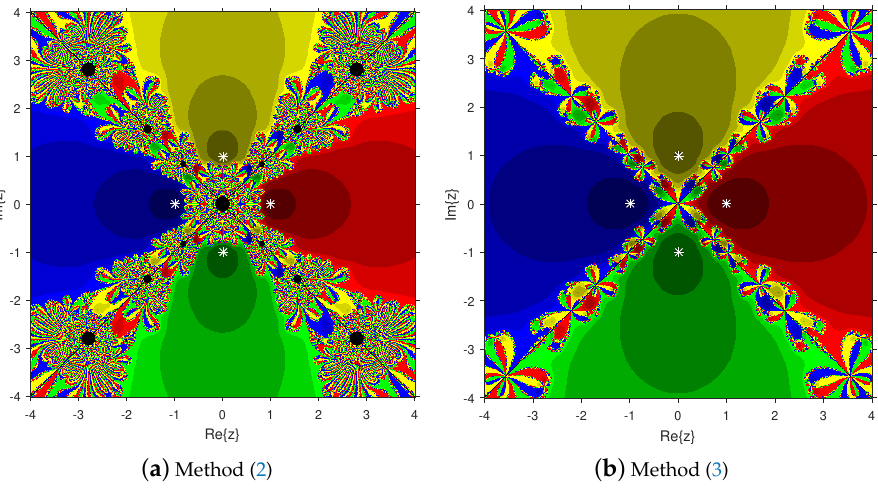
Figure 3. Comparison of attraction basins associated with fourth-degree polynomial O 3 ( z ) = z 4 − 1.